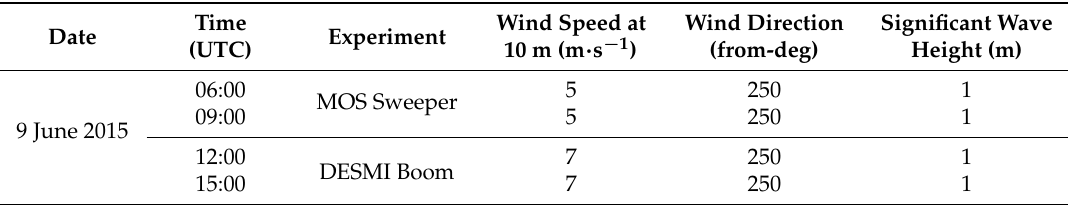
Table 2. Environmental Conditions during the